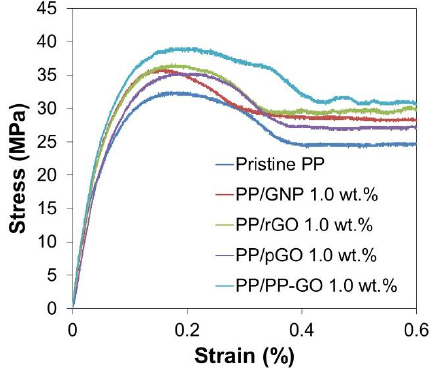
Figure 8. Tensile stress-strain curves of PP nanocomposites. Table 3. Tensile properties of PP nanocomposites.